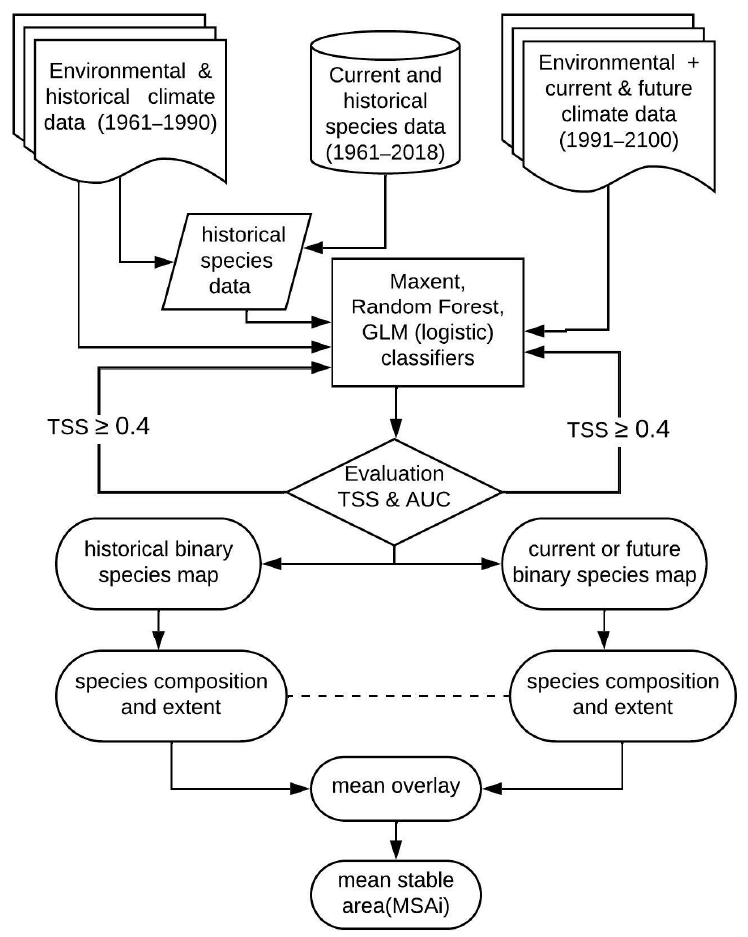
Figure 1. Summary of research methods and workflow.